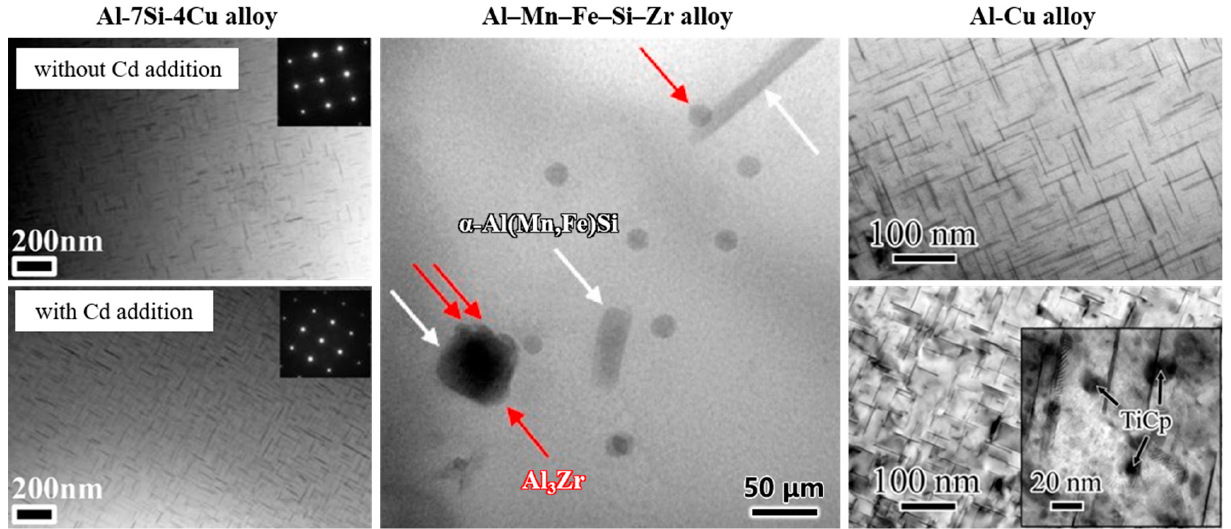
Figure 10. TEM micrograph of second phases in Al-7Si-4Cu alloy, reprinted with permission from ref. [106]. 2022, Elsevier; Al-Mn-Fe-Si alloy (Al 3 Zr and α -Al(Mn, Fe)Si are marked by red and white arrows, respectively), reprinted with permission from ref. [107]. 2022, Elsevier; Al-Cu alloy, reprinted with permission from ref. [49]. 2022, Elsevier.